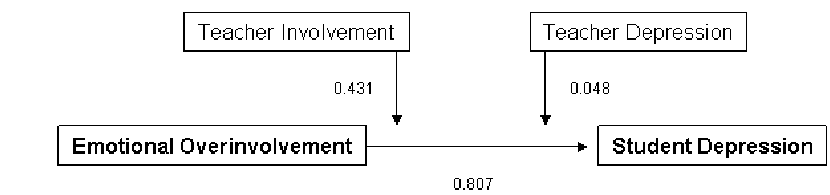
FIGURE 1 . Emotional overinvolvement to student depression: cross-level interactions.